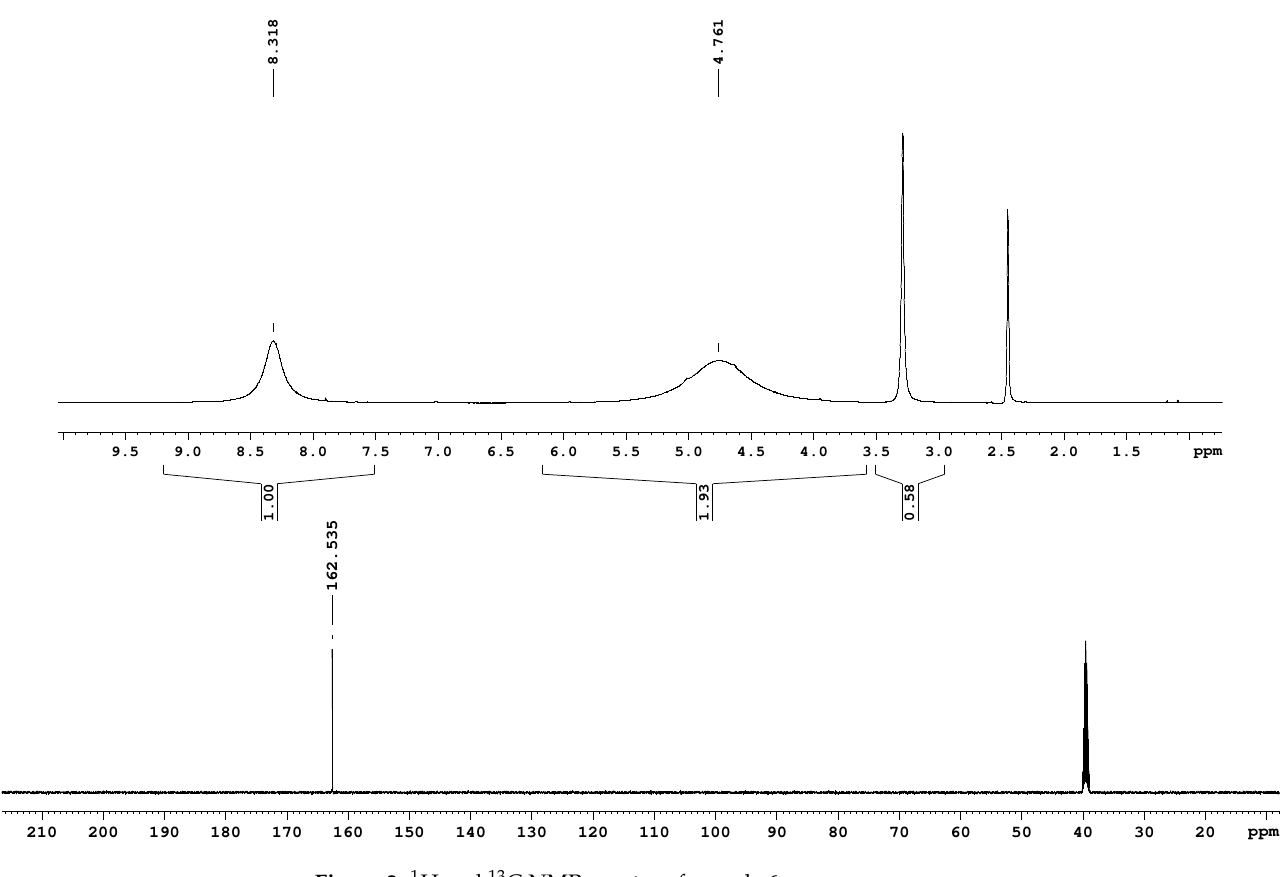
Figure 2. 1 H and 13 C NMR spectra of sample 6.